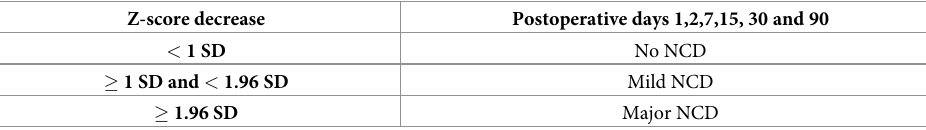
SD: standard deviation. NCD: neurocognitive